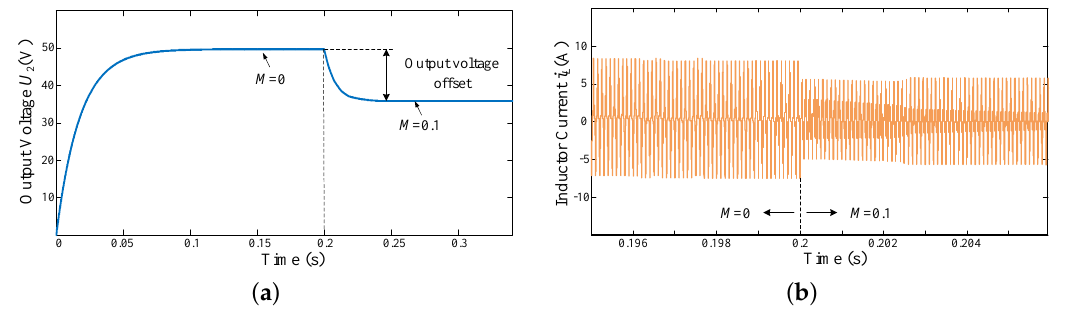
Figure 3. Transient waveforms of DAB converter switching from ideal TPS control to actual TPS control with U 1 = 100 V, P = 125 W, n = 1, D 1 = 0.68, D 2 = 0.316, and D 3 = 0.37: ( a ) transient waveform of output voltage; and ( b ) transient waveform of inductor